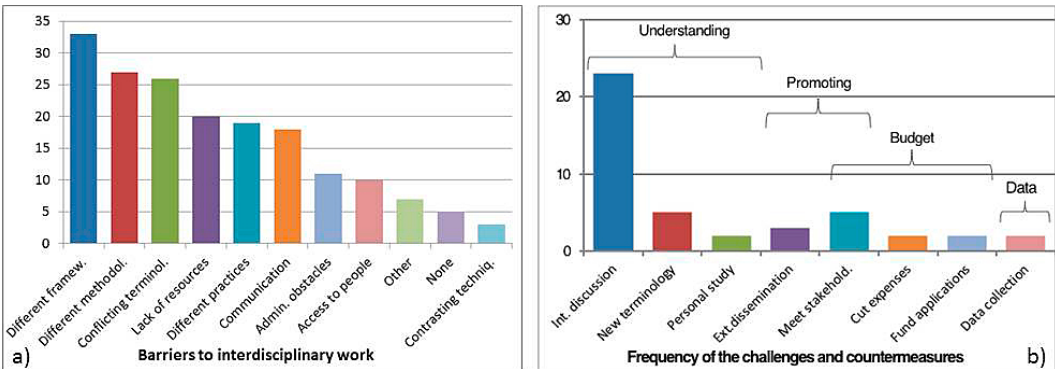
fig. 7. Barriers in disaster resilience projects in descent order of frequency (a) and actions undertaken to solve them (b), organized in macro-categories aimed at solving problems of: understanding (60%); promotion (26%); budget (19%); lack of data